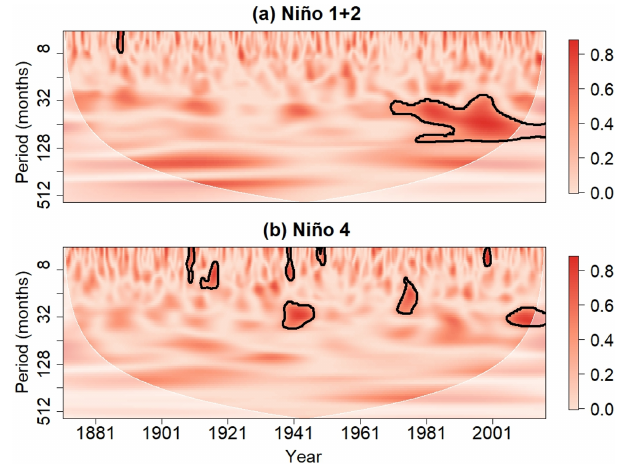
Figure 8. Local auto-bicoherence spectra of the (a) Niño 1 and 2 and (b) Niño 4 indices. Contours enclose regions of 5% cumula- tive area-wise significance, and the shading represents the cone of influence.